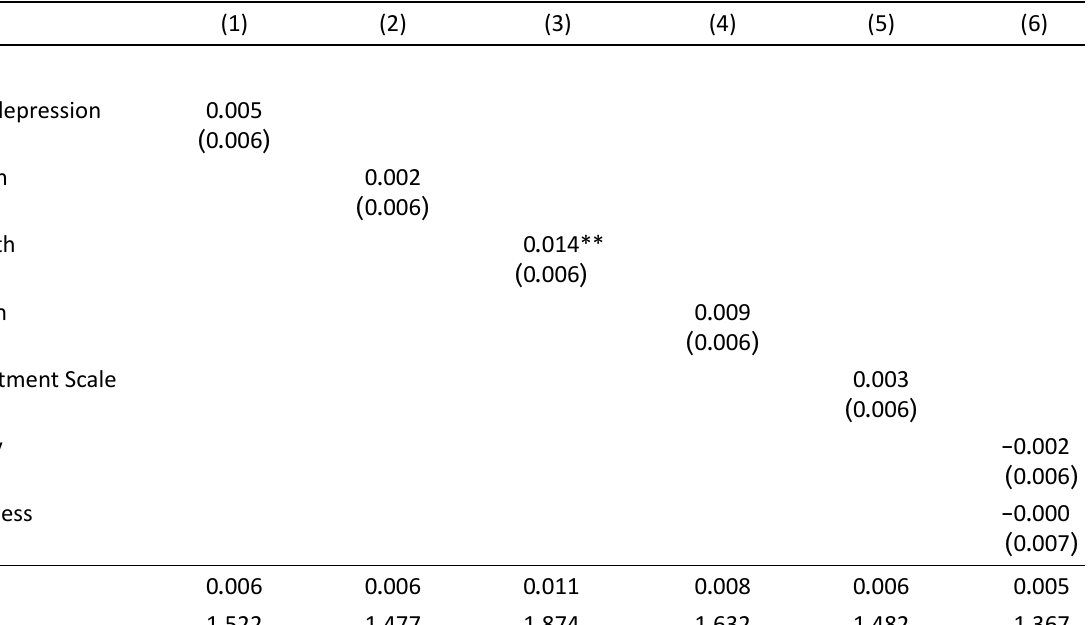
Table 1. Finding a first job within six